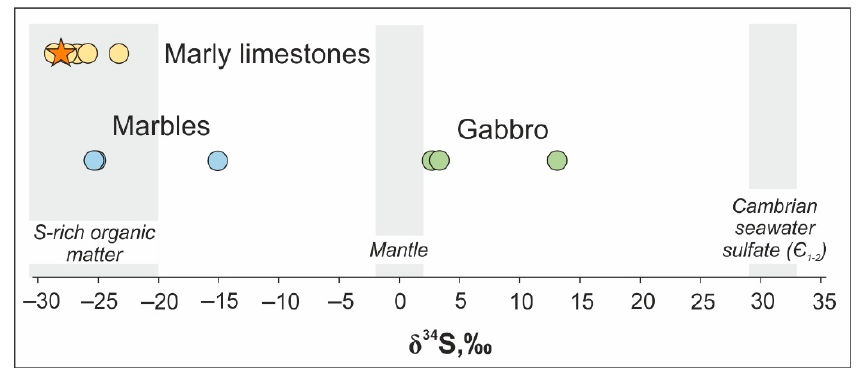
Figure 18. Sulphur isotope composition of sulfides (mainly pyrrhotite) from recrystallized marly limestones, marbles and gabbro from the Kochumdek contact aureole in comparison with stratotype marly limestone of the Lower Kochumdek Sub-formation (orange star) (based on data from Table 12) and with data for S-rich organic matter after [88], mantle after [28], and Cambrian seawater sulfate after [90].